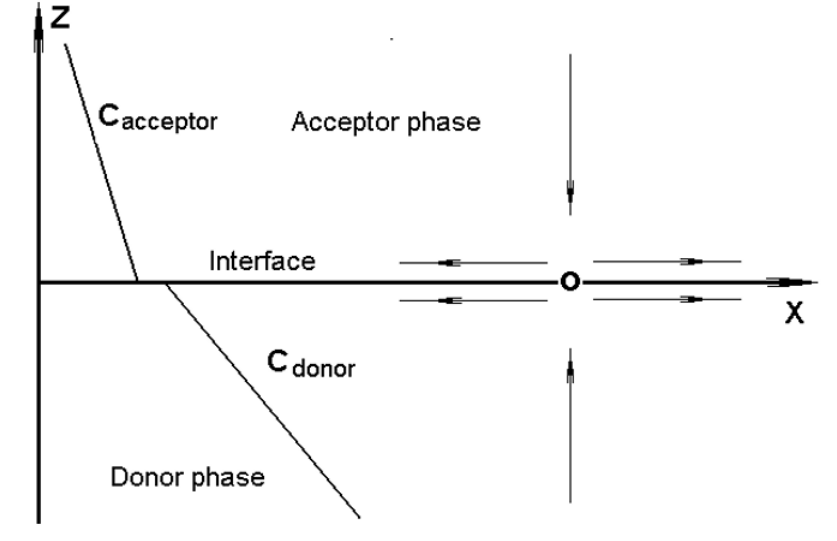
Figure 1. Mechanism of the solutal Marangoni